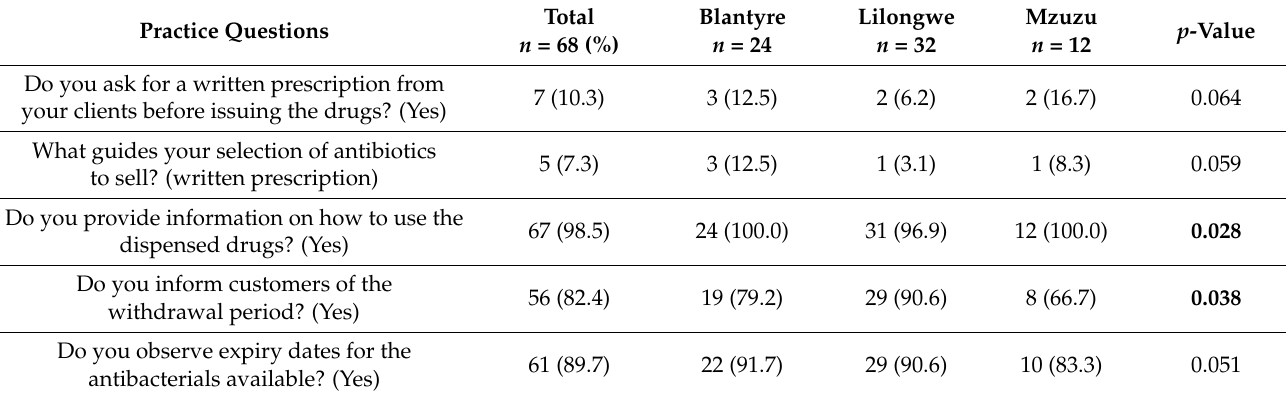
Table 3. The proportion of respondents who correctly/positively responded to practice questions regarding dispensing of antimicrobials across the study